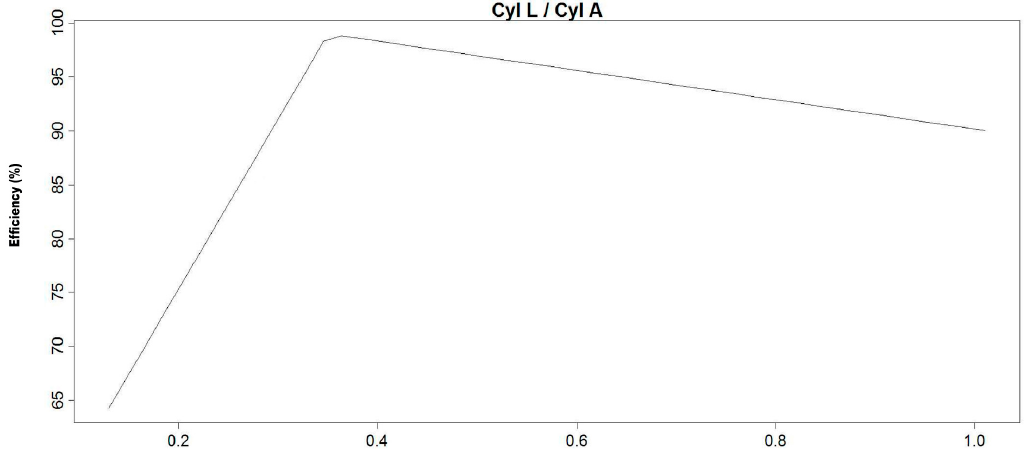
Figure 5. Graphical representation of the basis functions of the MARS model number one and their coefficients for feed into the vortex the ratio CL to CA relative to separation efficiency.